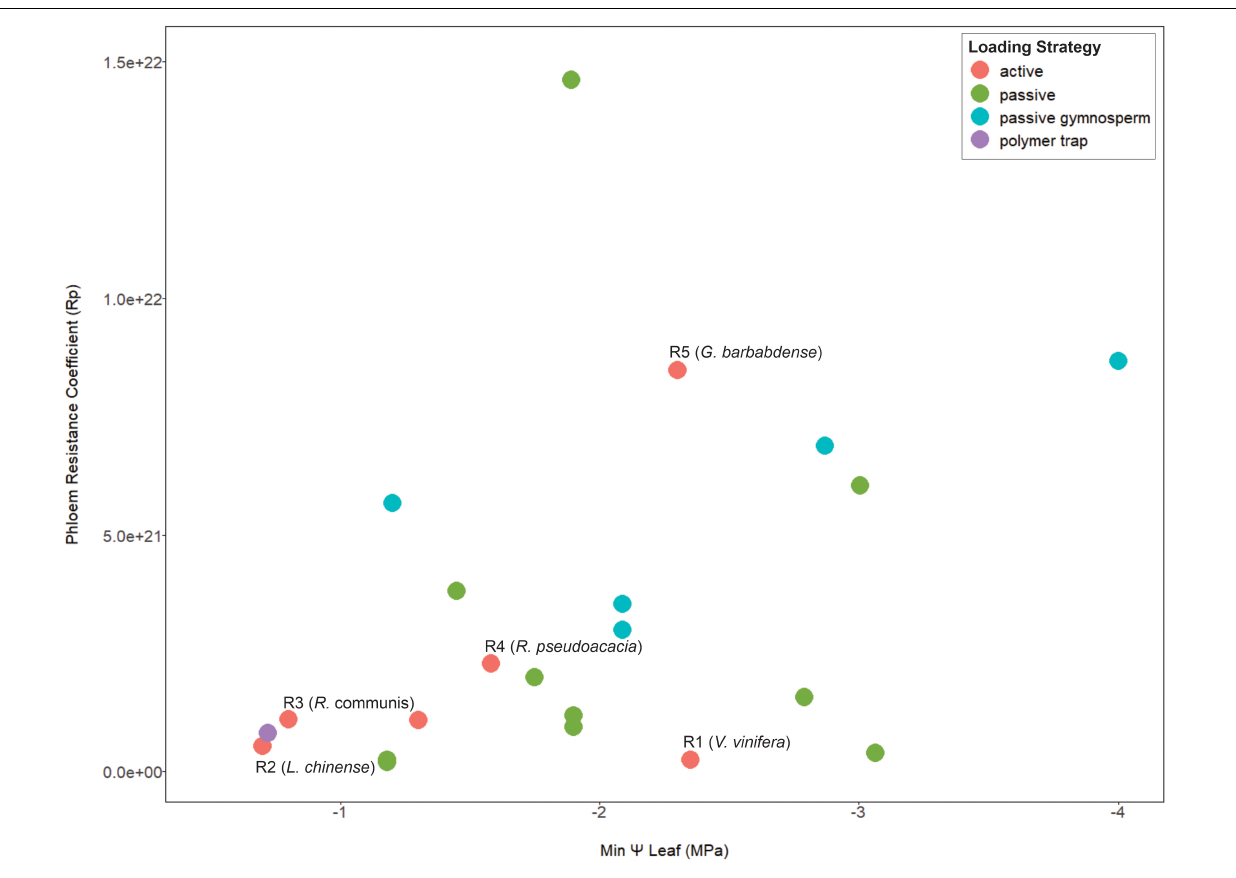
FIGURE 1 | A meta-analysis scatterplot for phloem resistance coefficients and minimum mid-day leaf (cid:57) that show no association between these two parameters in terms of loading type. Points are color coded by species phloem loading strategy. The species used in the model simulations are indicated from R1–R5 in order of increasing pathway resistance. Anatomical data is from Liesche et al. (2017) and scaled equally to obtain a phloem pressure of > 0.6 MPa for all resistance values. Minimum mid-day leaf (cid:57) was obtained from Choat et al. (2012) and Bartlett et al. (2016). See Supporting Information Table 1 for data and references used for loading types. Here we assume Gymnosperms are passive loaders, although a systematic study of this taxa for loading mechanism is still warranted (Liesche et al., 2011b; Liesche,